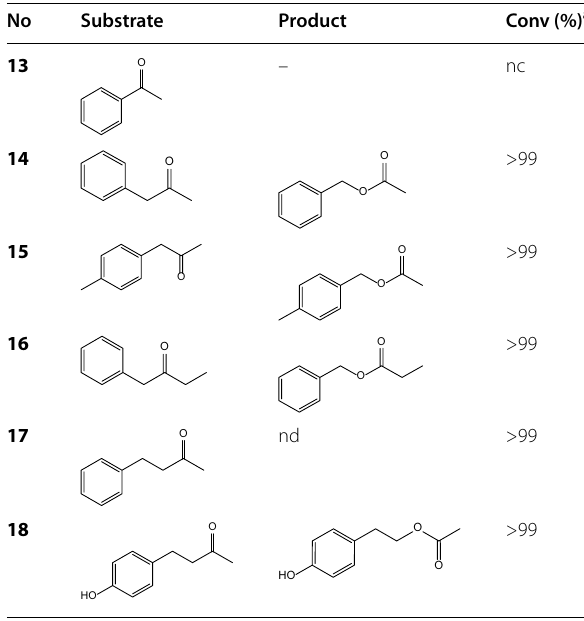
Table 2 Biotransformation of aromatic ketones mediated by BVMO